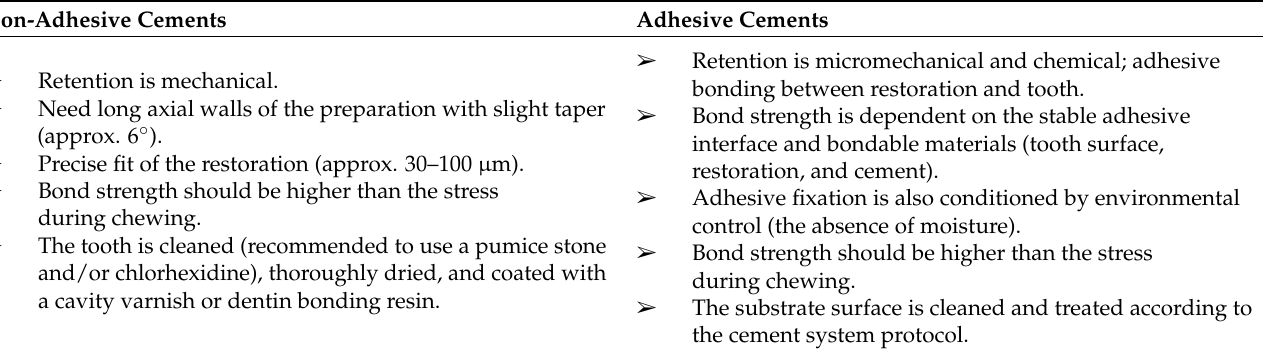
Table 1. General characteristics of non-adhesive and adhesive